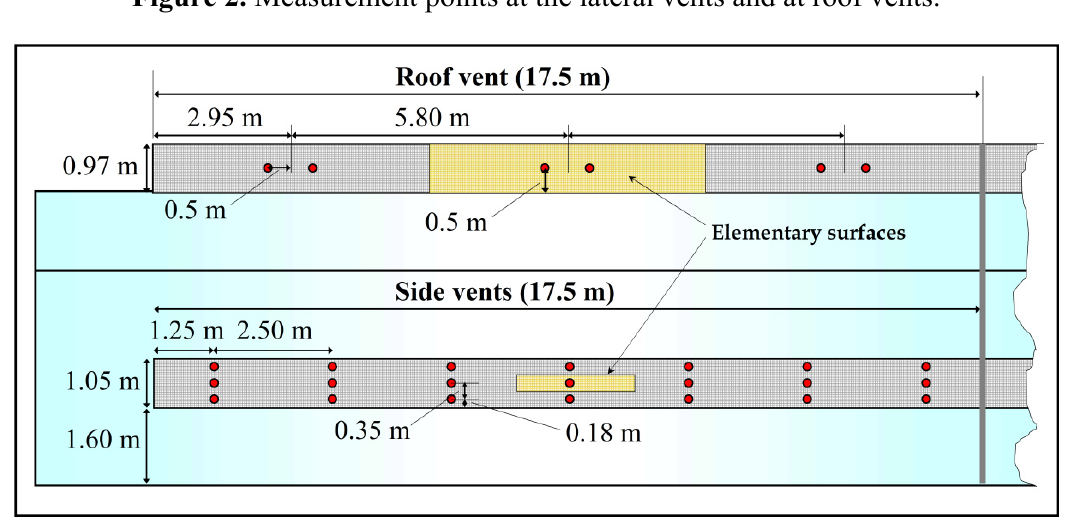
Figure 2. Measurement points at the lateral vents and at roof vents.